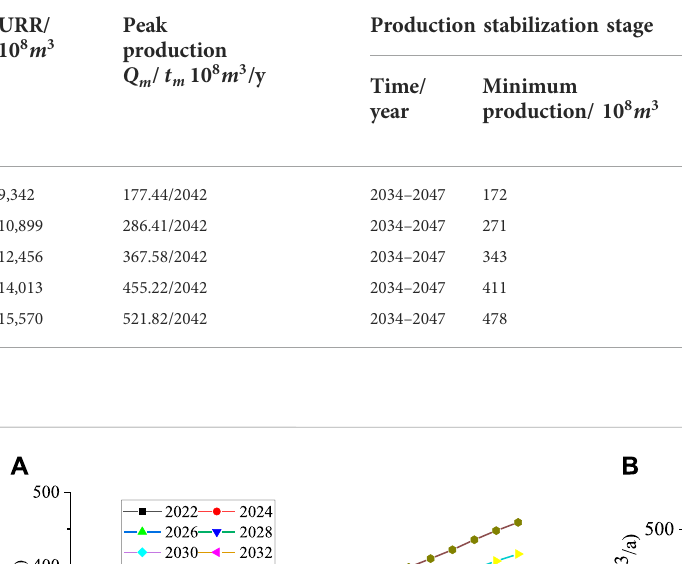
TABLE 2 Production prediction results of shale gas under different URR .